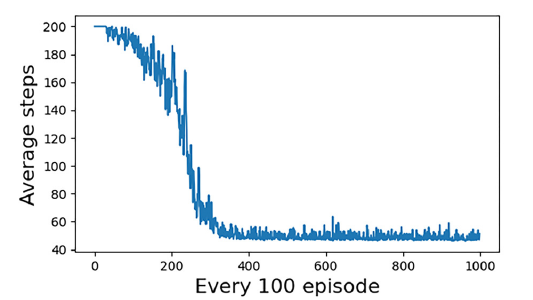
Figure 6. Our UCAV reward change curve in case 1.